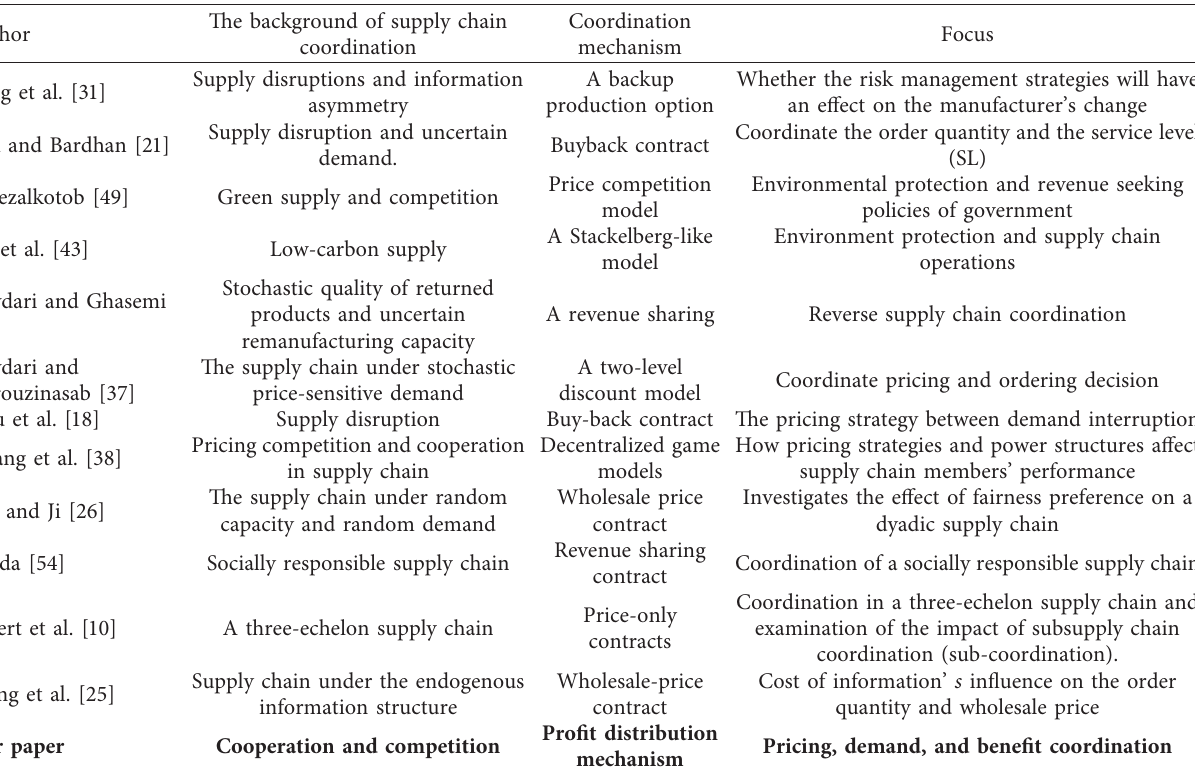
Table 1: Our paper vs.